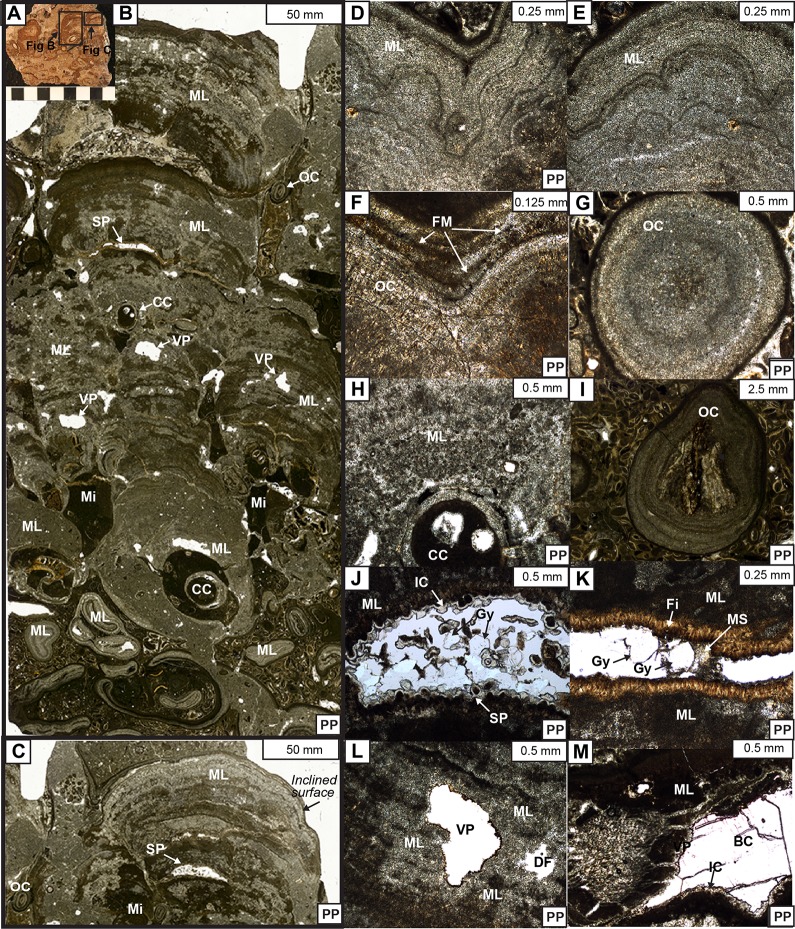
Photomicrographs of the microlaminated micrites.(A) Hand sample photo of the boundstone. (B) Microlaminated micrite forming finger-like columnar fabrics. (C) Cone shaped microlamination. (D) Crinkled, wavy lamination with inclined surface. (E) Crinkled, wavy lamination. (F) Flocculated micrite grain trapped/bound between laminations. (G) Sphere shaped oncoidal fabric in cross section. (H) Caddisfly case bound by fine laminations. (I) Sphere oncoidal fabric with a plant nuclei. (J) Shelter porosity and its associated cements. (K) Shelter porosity and its associated cements. (K) Shelter porosity and its associated cements. (L) Vugular porosity. (M) Vug porosity and its associated cements. CC-caddisfly case; ML- microlaminated micrite; Mi-micrite matrix; SP- shelter porosity; VP- vugular porosity; OC-oncoid; FM- flocculated micrite; MS- granular microspar; IC-isopachous calcite; BC- blocky calcite; Gy- gypsum; Fi- fibrious calcite.